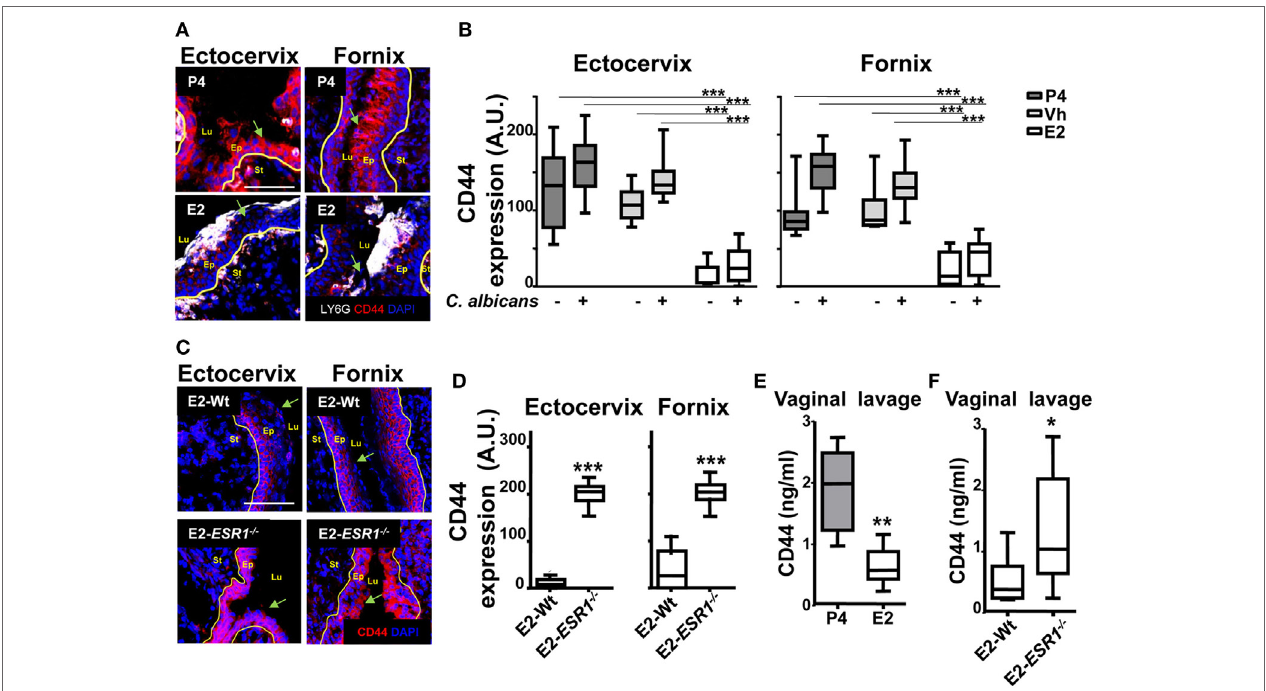
FigUre 8 | CD44 expression in the female reproductive tract (FRT). Hormone-treated ovariectomized mice were mock or Candida albicans inoculated in the vagina. (a) FRT indicated anatomical regions CD44-stained (red) and LY6G-stained neutrophils (white). (B) CD44 expression in the apical epithelium. Data were calculated in at least three different points in three different sections of each sample ( n = 5). (c) Estradiol treated ESR1 − / − and Wt mice challenged with C. albicans . Representative photographs of ectocervix and fornix stained with CD47 (red) and (D) quantification ( n = 5). (e) CD44 was assayed by ELISA in the vaginal lavage of hormone treated C. albicans inoculated mice and (F) estradiol-treated ESR1 − / − and Wt mice challenged with C. albicans . Data are expressed as box and whiskers 10–90 percentile ( n = 5). * p < 0.05, ** p < 0.01, and *** p < 0.001 Mann–Whitney. Yellow line indicates the lamina propia. Scale bar, 200 µm. E2, estradiol; Vh, vehicle; P4, progesterone. Abbreviations: Lu, lumen; Ep, epithelium; St, stroma; A.U., arbitrary units.